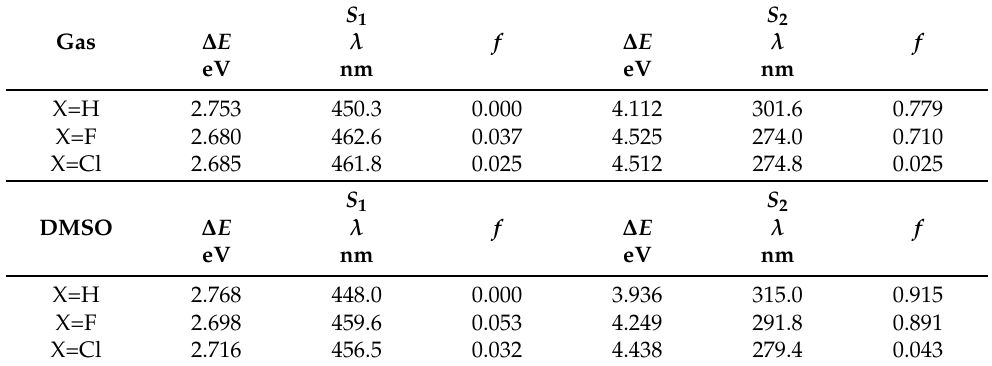
Table 1. Vertical excitation energies, excitation wavelengths and oscillator strengths of the two lowest singlet electronic excited states of the E tetra- ortho -substituted azobenzenes in gas phase and in